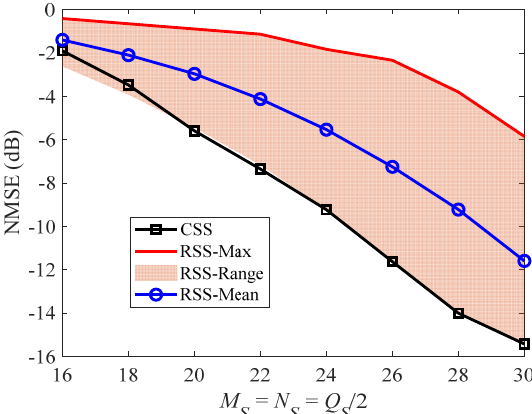
Figure 20. NMSEs of the RSS method and the CSS method against the number of selected antennas and sub-pulses.